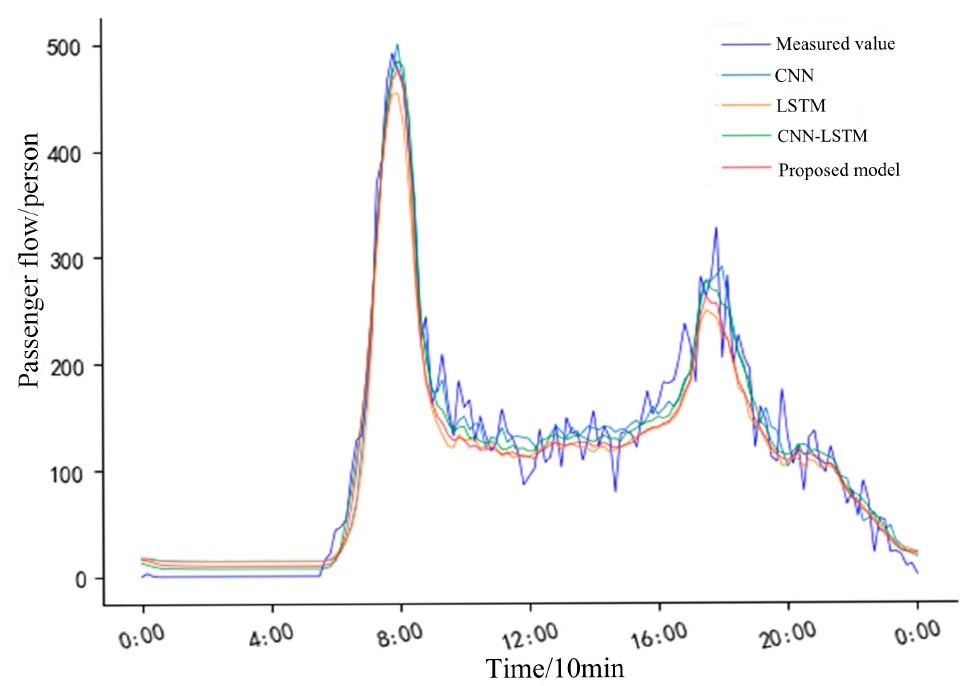
Figure 8. Comparison of passenger flow forecast of various models (Linping station, January